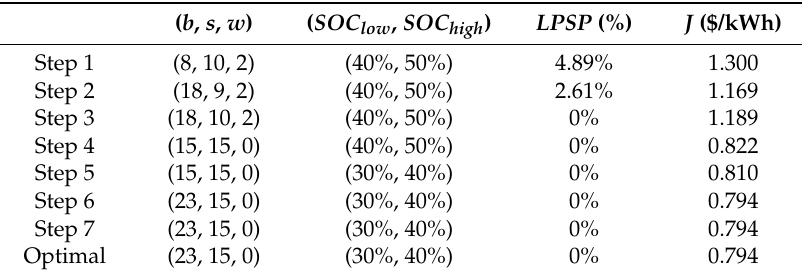
Figure 6. The reference plots for the household load. Table 5. The optimal design procedure for the house load.